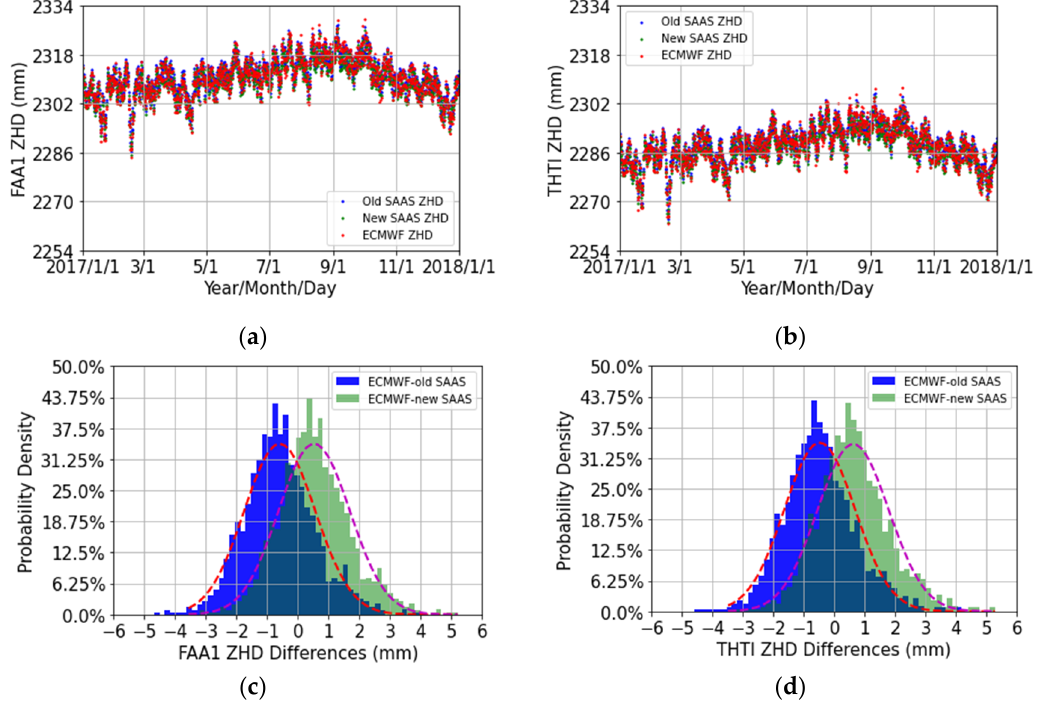
Figure 6. Comparisons of the new-SAAS ZHD estimates (green dots) and the old-SAAS ZHD estimates (blue dots) with the ZHD estimates from VMF1/ECMWF (red dots) for the FAA1 station ( a ), and the THTI station ( b ) , and the histograms of their corresponding ZHD estimates differences at FAA1 station ( c ), and THTI station ( d ).